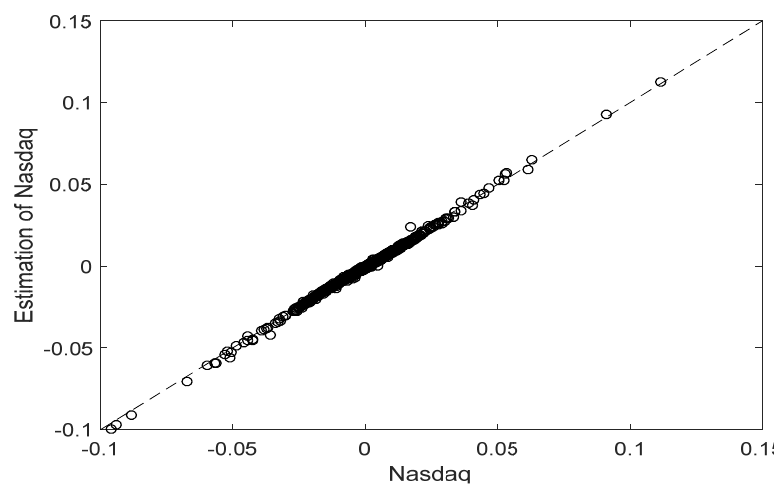
Figure 2. Q-Q plot of the NASDAQ return time series and the estimated one after the scaling procedure. The result of Kolmogorov-Smirnov goodness of fit test and the small value of the mean squared error (MSE) confirm the above conclusion, as